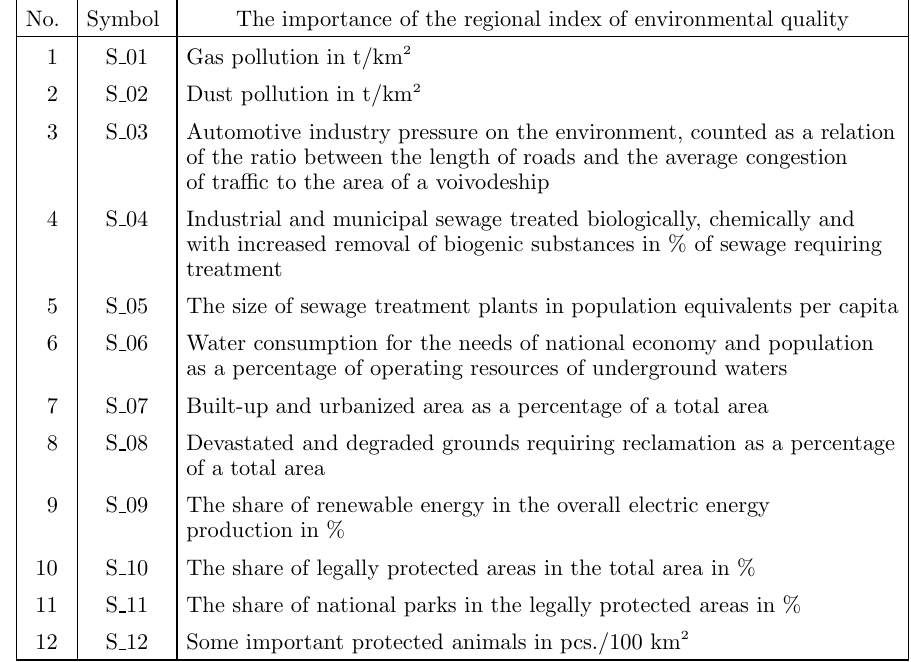
Observable variables of the synthetic index of environmental quality (JS) No.